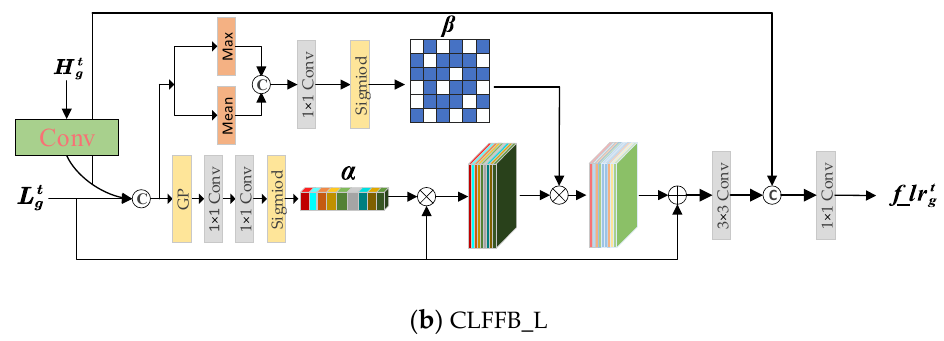
Figure 4. The proposed CLFFB, ( a ) is the SR branch represented as CLFFB_S, ( b ) is the LR branch denoted as CLFFB_L.